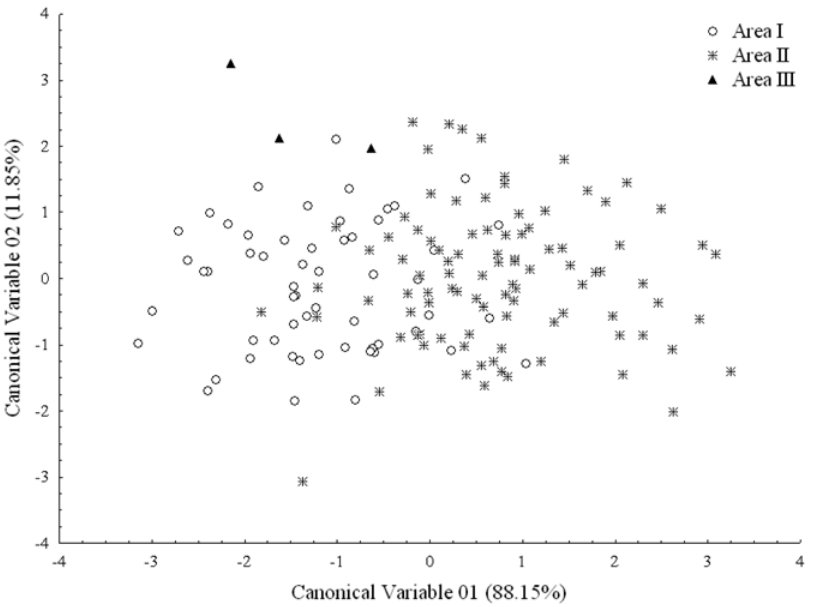
Fig. 7 - Graphic dispersion between the bees T. diversipes in each area, in relation to Cartesian axes established by canonical variables (CV1,